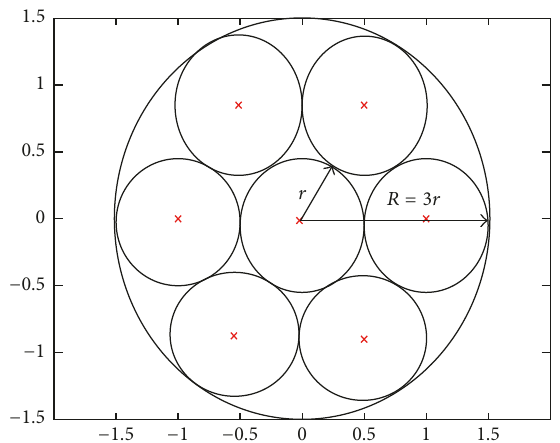
Figure 2: Diagram of the method for determining the area division